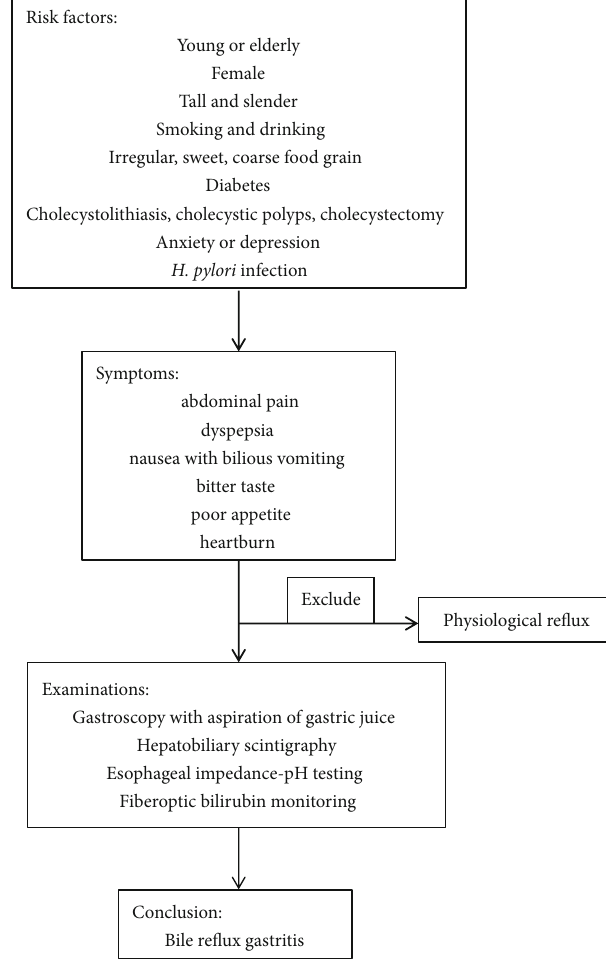
Figure 2: Flow chart for the diagnostic